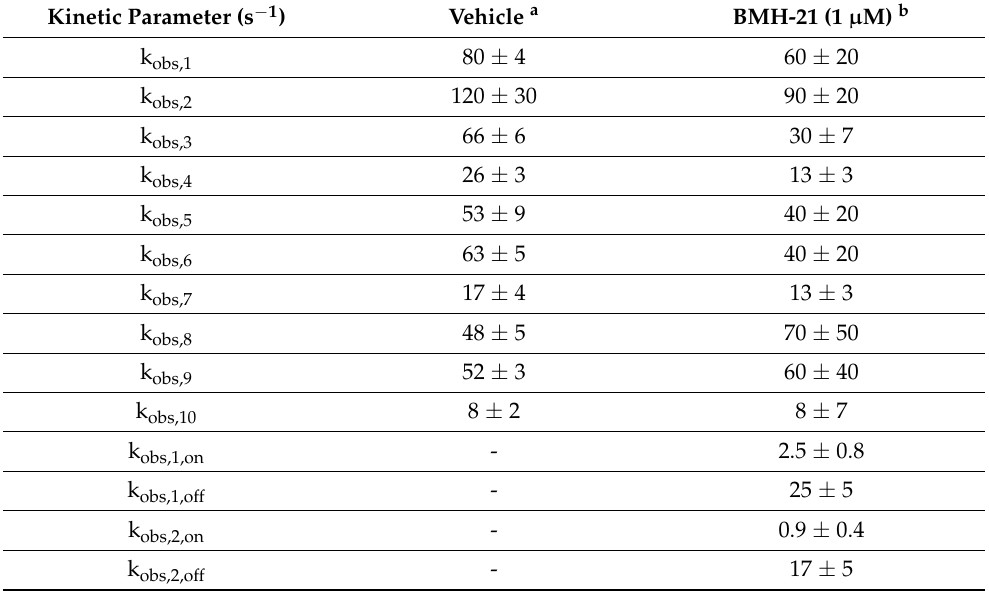
Table 1. Resultant parameter values from Pol I vehicle- and BMH-21-treated multi-nucleotide time